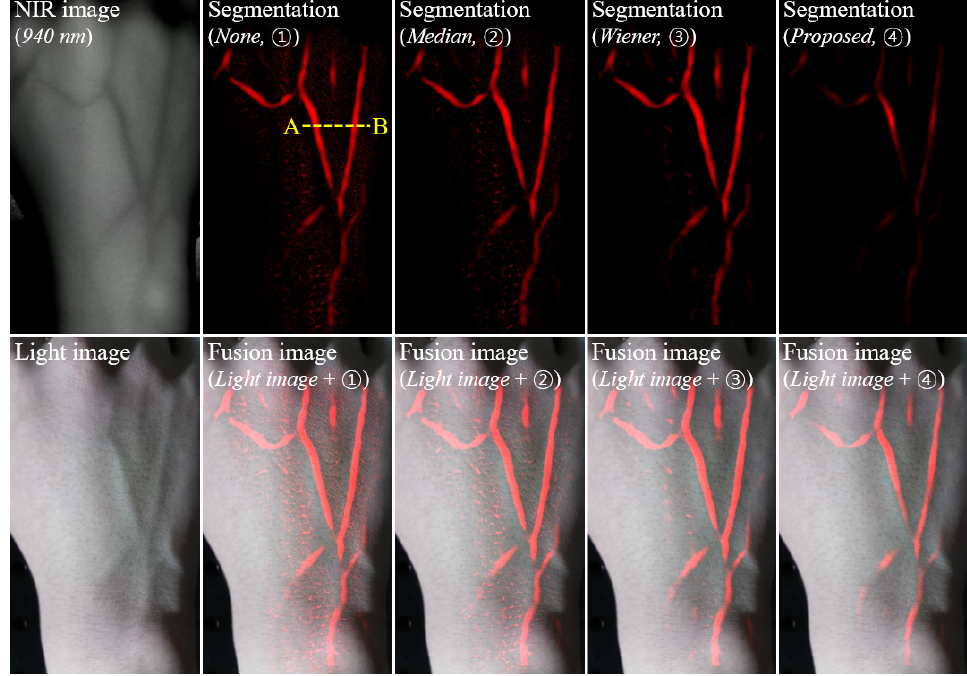
Figure 5. Examples of vein segmentation images ( top ) of the right hand for a 940 ‐ nm NIR image (none ( ① ), the median filter ( ② ), the Wiener filter ( ③ ), and the proposed filter ( ④ ) and the fusion images with the vein image on the top ( bottom ). These results exhibited a similar tendency to those for the 850 ‐ nm NIR image and the vessel extraction results, indicating that excellent visibility can be obtained using the proposed algorithm.